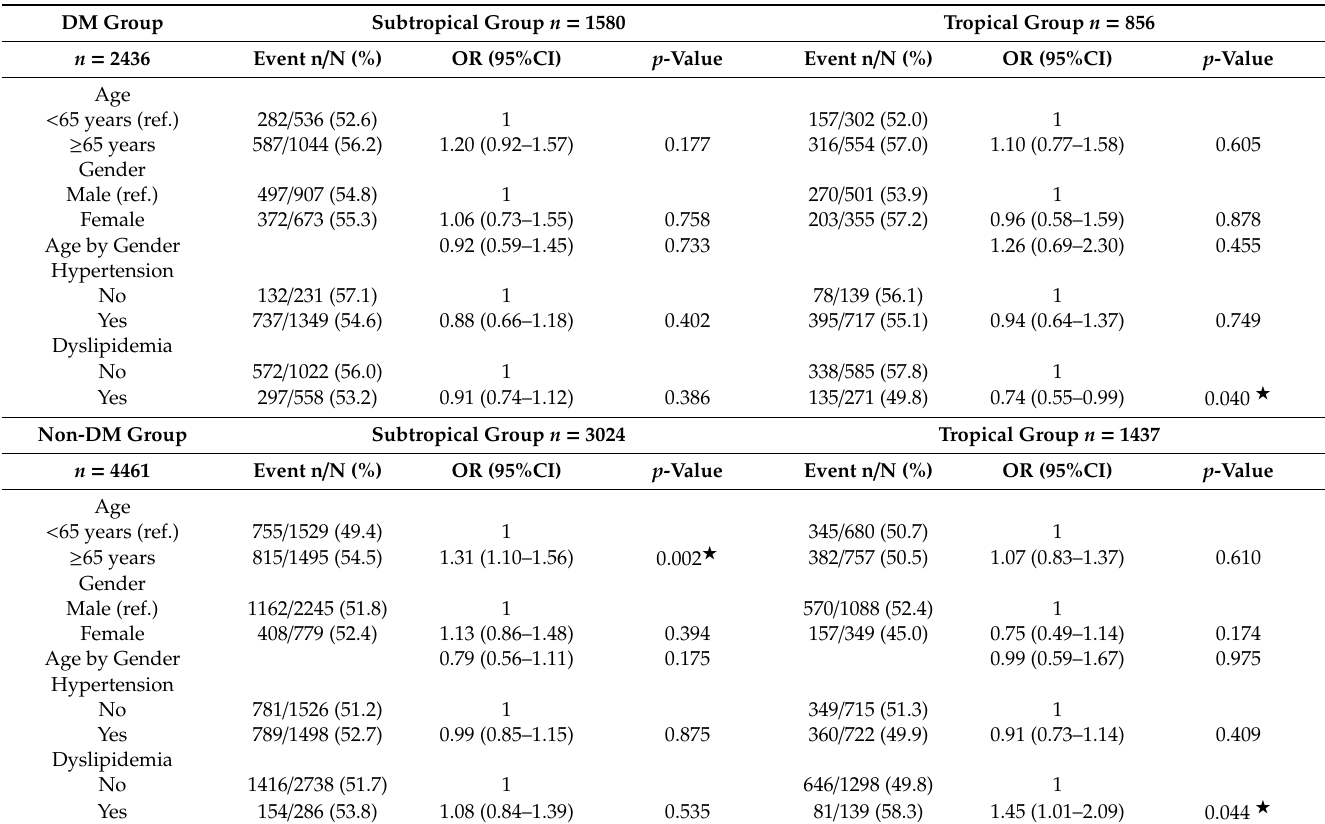
Table 6. The association of the cold season with AMI hospitalization among the DM group and the non-DM